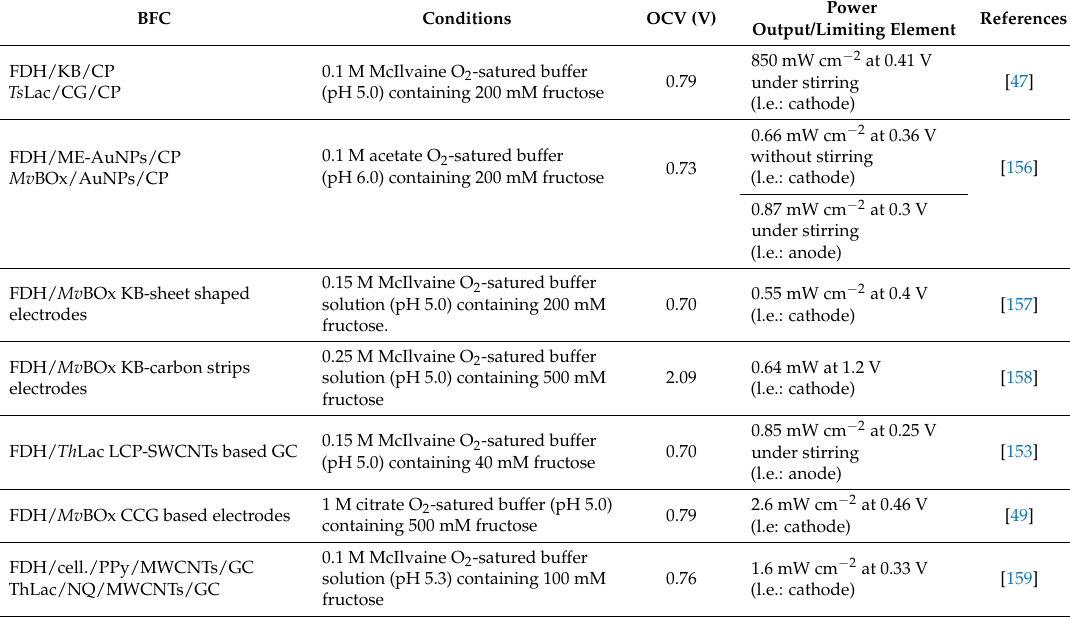
Table 5. DET-based fructose/O 2 EFCs are compared based on some of the operational parameters like operating conditions, open-circuit voltage (OCV), power output and operational stability. Abbreviations: AuNPs gold nanoparticles, CCG carbon cryogel, cell. Cellulose, CG carbon aerogel,